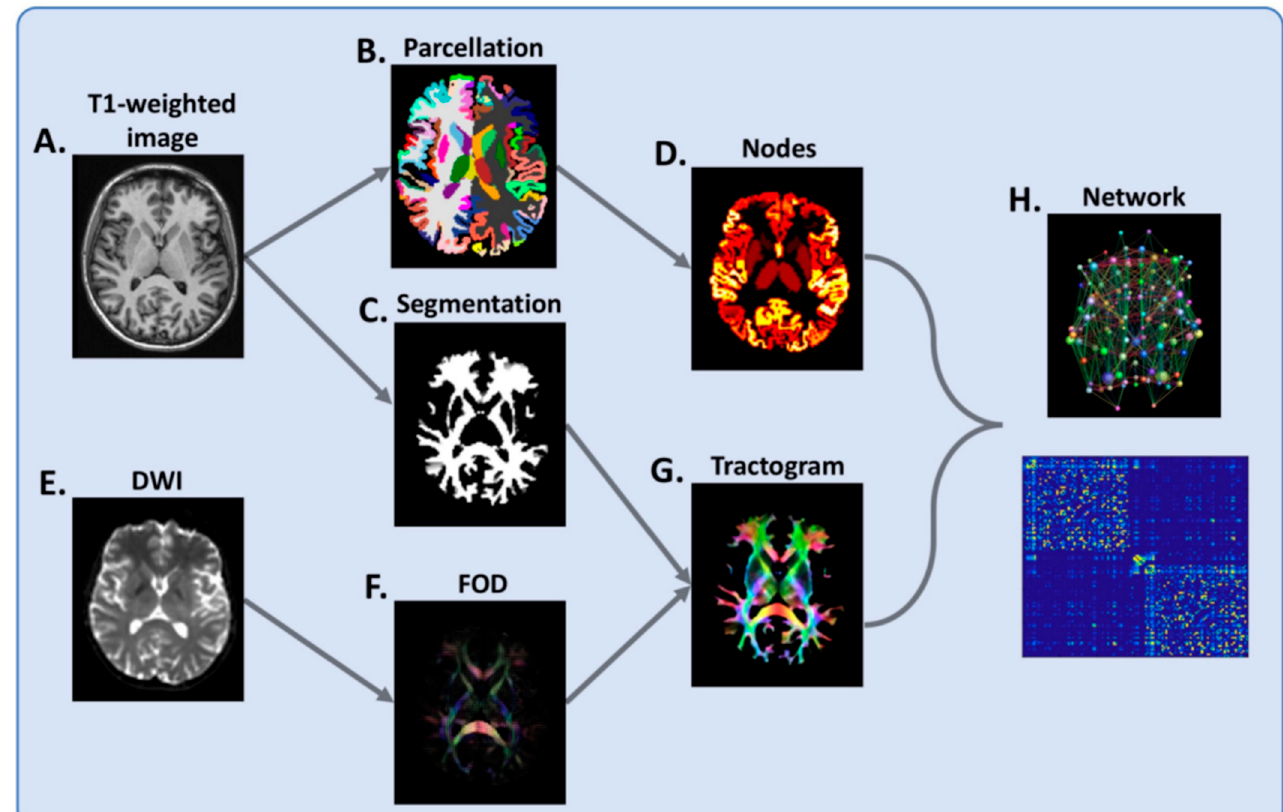
Figure 3. Flowchart of brain network reconstruction. For each subject, ( A ) T1-weighted image is segmented into grey matter ( B ) and white matter ( C ). The grey matter segmentation is parcellated into cortical and deep grey matter regions ( B ), which serve as network nodes ( D ) in the subsequent network-based analysis. From a diffusion-weighted image (DWI) ( E ), voxel-wise fiber orientation distribution (FOD) ( F ) is estimated and whole-brain tractography undertaken ( G ), with the white matter segmentation ( C ) used to prevent this from spilling into grey matter. Finally, nodes and tractogram are modelled into a network ( H ). Connections are weighted by the sum of the pairwise streamline weights. Reprinted from JNNP , Vol. 90, Issue 2, 01 February 2019 [91]. Copyright: © 2021, with permission from BMJ Publishing Group Ltd.